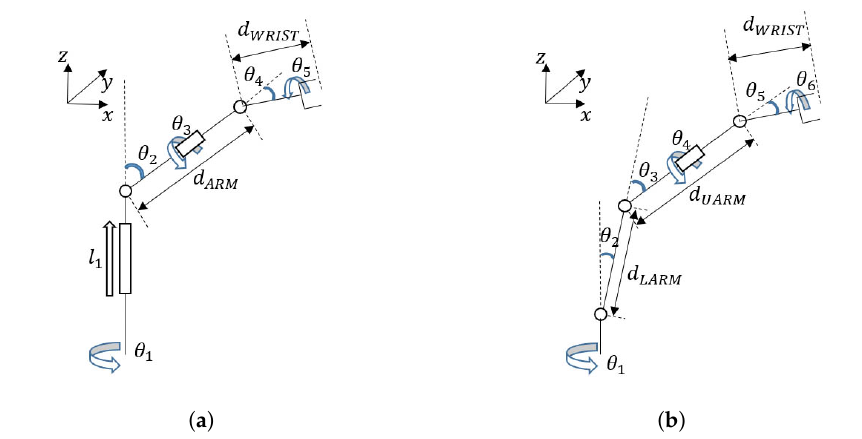
Figure 8. Arm configurations of HSR and MSR-1. ( a ) HSR Arm, ( b ) MSR-1